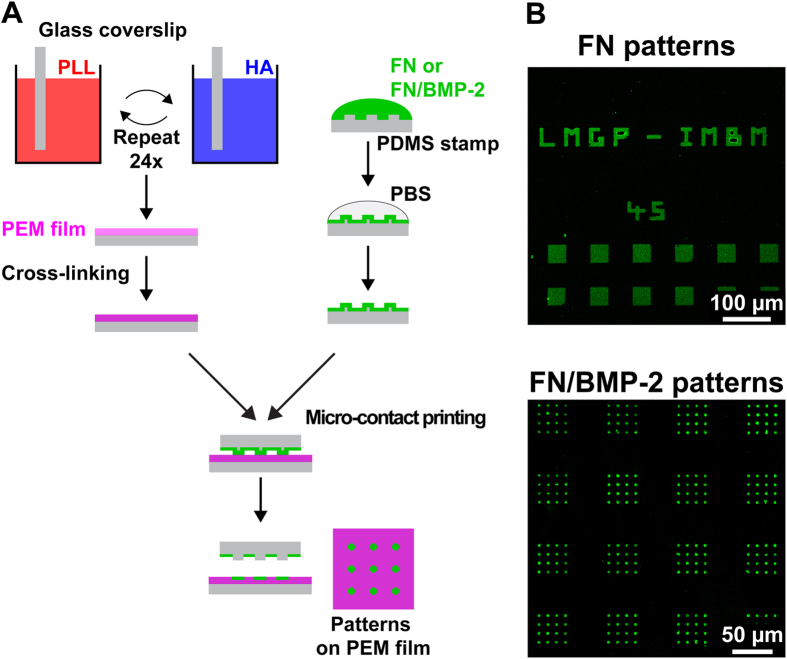
Microcontact printing of BMP-2 on soft biopolymeric films.(A) Schematic of the LbL buildup and crosslinking of (PLL/HA) films combined with microcontact printing (the ink containing either FN alone or BMP-2 within FN) for generating micropatterns of FN or FN/BMP-2 on soft (PLL/HA) films. (B) Representative images depicting the faithful reproduction of the photomask spatial features into FN (with 10% of fibrinogenA488) and FN/BMP-2CF micropatterns.